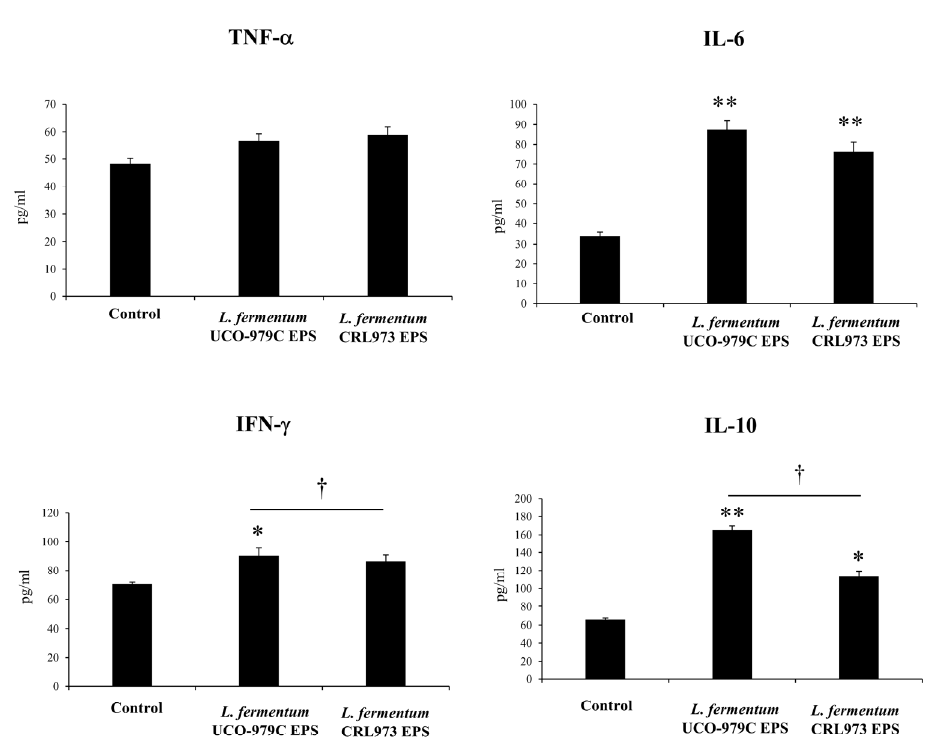
Figure 7. E ff ect of Lactobacillus fermentum UCO-979C or L. fermentum CRL973 EPS on cytokine and chemokine production of human macrophages (THP-1 cells). THP-1 cells were incubated with 100 µ g / mL of L. fermentum UCO-979C or L. fermentum CRL973 EPS. The levels of TNF- α , IL-6, IFN- γ and IL-10 (pg / mL) in culture supernatants were determined 24 h after stimulation. The results represent data from three independent experiments. Results are expressed as mean ± standard deviation. Significant di ff erences when compared to the control group: * ( p < 0.05), ** ( p < 0.01). Significant di ff erences when compared to the indicated group: † ( p < 0.05).